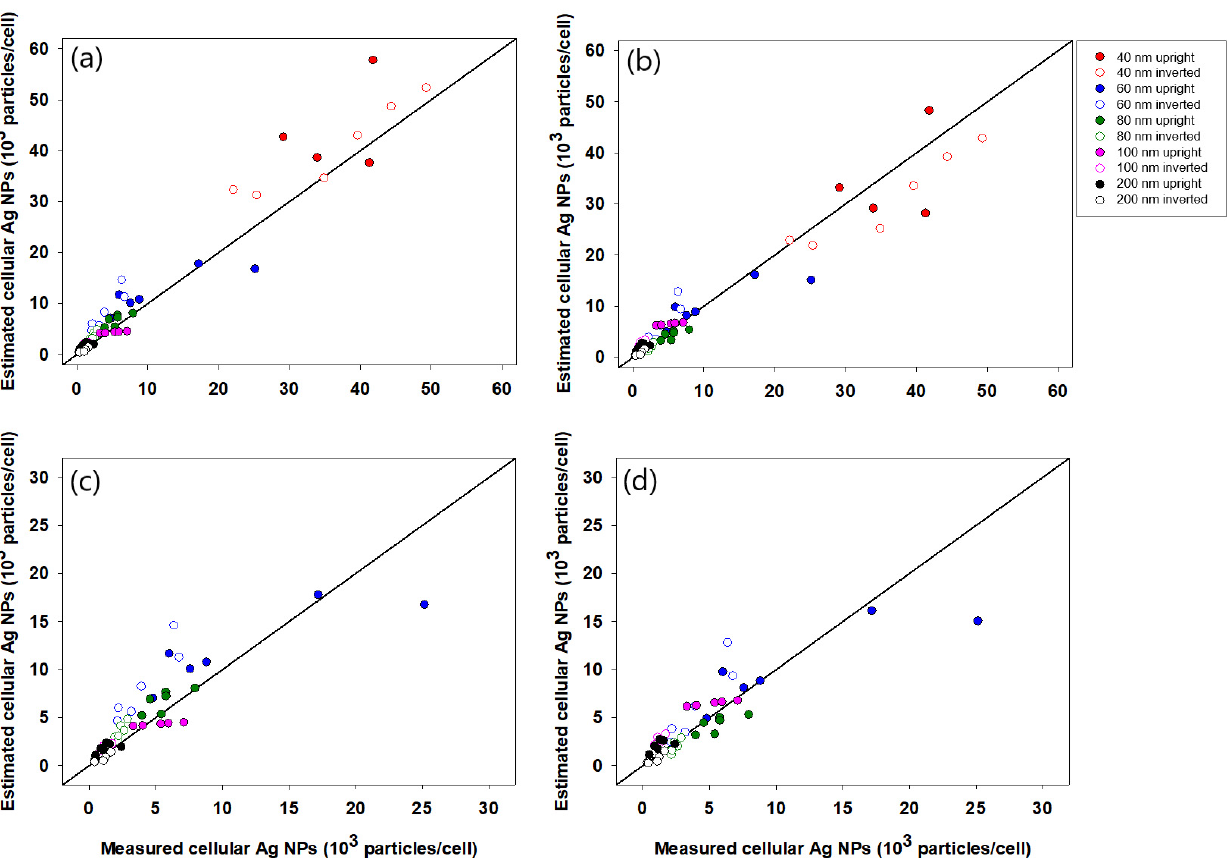
Figure 5. Validation of model equations. Measured number of c-Ag NPs was compared with estimated values using ( a , c ) separate equations for each particle size and ( b , d ) one equation incorporating particle size. Panels ( a ) and ( b ) show validation results for all 5 particle sizes, whereas panels ( c ) and ( d ) exclude Ag 40 NPs.